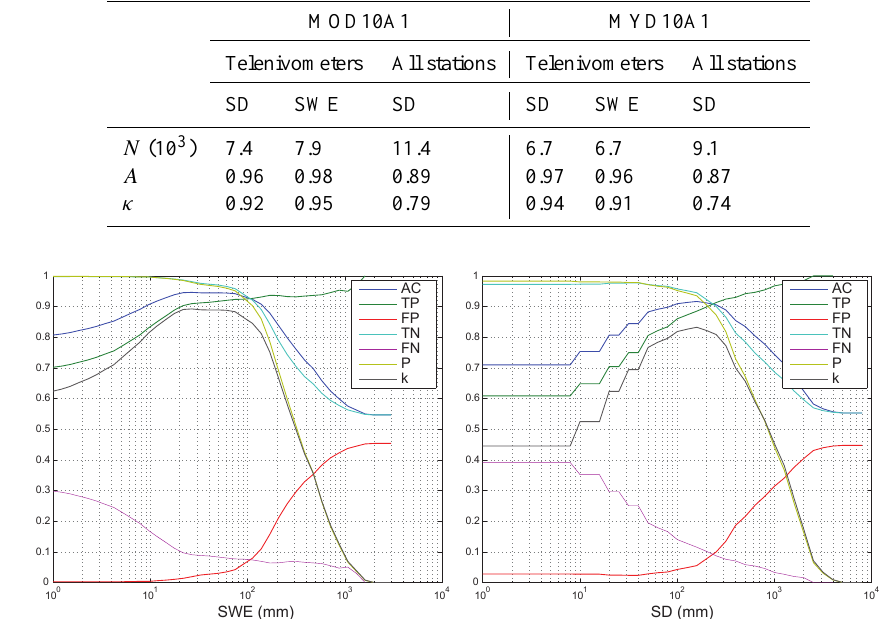
Figure 4. Comparison of MODIS products with in situ data. Each graph shows the variation of the statistical agreement between both data sets with the snow detection threshold. Left: the detection threshold is in SWE and evaluated with measurements from the telenivometers. Right: the detection threshold is in SD evaluated with all available stations (telenivometer and Météo-France). AC: overall accuracy, TP: true positive, FP: false positive, TN: true negative, FP: false positive, P : precision, k : kappa